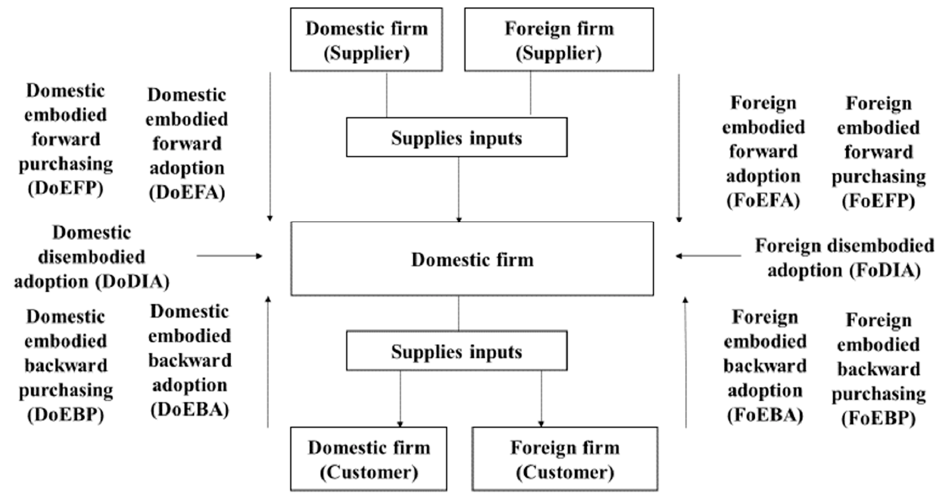
Figure 1. Definition of technology adoptions. Source: Authors’ modification from Newman, Rand, Talbot and Tarp [24] .